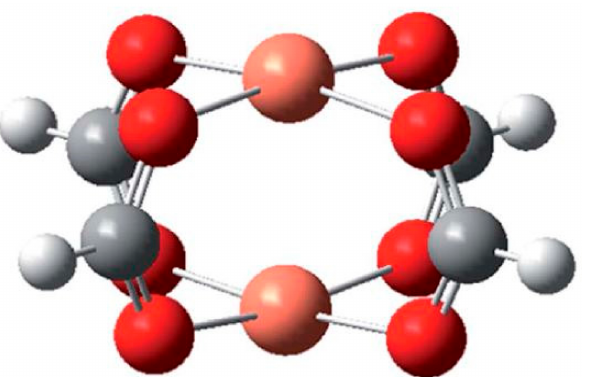
Figure 28. Cluster model used for the density functional theory (DFT) calculations of M-HKUST-1. Reprinted with permission from Ref. [133]. Copyright 2019 Royal Society of